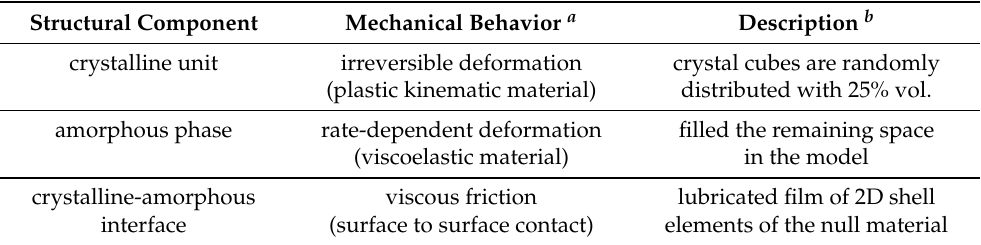
Table 1. Key structural components of Araneus diadematus dragline silk and their mechanical behavior from all-atom simulations to FEM simulations. Structural